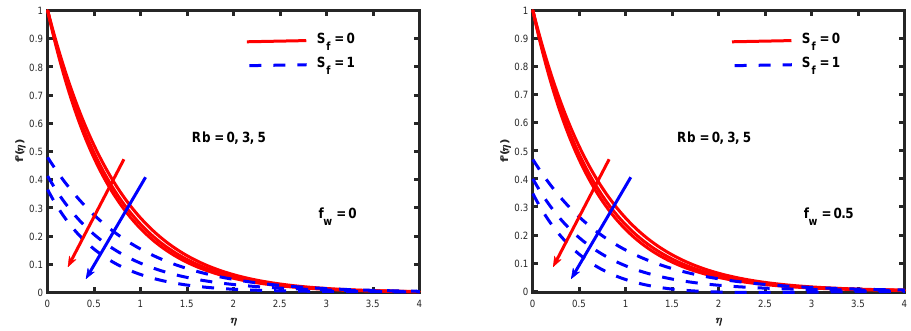
Figure 5. Influence of Rayleigh number and hydrodynamic slip on velocity. From Figure 6, the effect of mixed convection parameter λ along with hydrodynamics slip S f on angular velocity is observed. It is seen that angular velocity increases with the rising values of λ and S f . However, angular velocity profile decreases for the rising values of f w (suction). Figure 7 describes the rise of material parameter K which causes a gradual increase to the angular velocity g ( η ) . From these figures, it is cleared that the angular velocity is promoted along with the expanding values of K and f w . Because the increment in K means larger vortex viscosity and hence stronger micro-rotation. However, with the increment in the hydrodynamic slip S f , the profile of g ( η ) decreases. Opposite behavior of g ( η ) is shown in Figure 8, for unsteady parameter δ . It is because the larger lays after the stretch in the sheet show the overall motion of the fluid. The temperature profile is plotted in Figure 9 with the values of magnetic number M and thermal slip S θ . The temperature θ ( η ) is gradually increasing directly with the increment in the inputs of these parameters. In addition, it is observed that the thermal profile decreases with the increment in f w . Figure 10 shows clearly that the effect of Brownian motion parameter Nb along with thermal slip S θ . It is observed that temperature rises with the rising values of Nb . According to the concept of Brownian motion, nanoparticles are directly related to temperature. With the increment in temperature, an enhancement yields in the kinetic energy of these